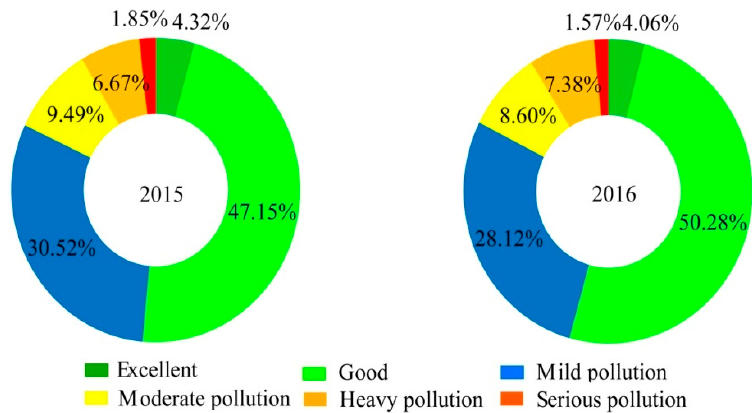
Figure 3. Proportion of days with different air quality levels at the province scale in 2015–2016.